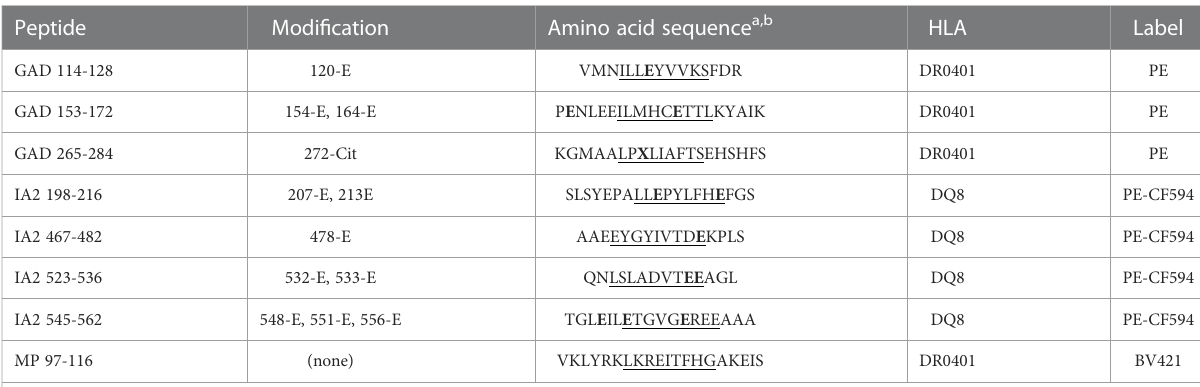
TABLE 1 Summary of PTM epitope tetramers used for T cell studies.